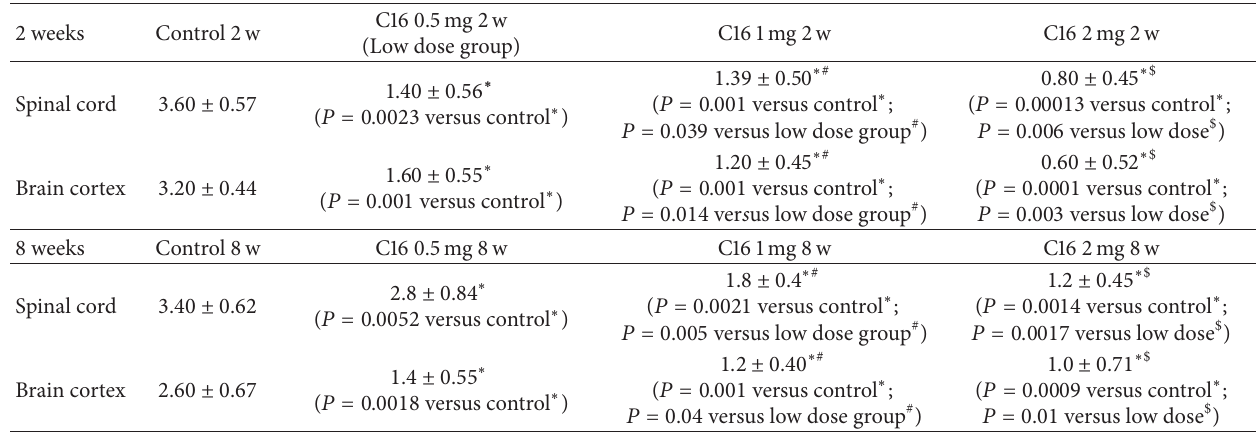
Table 2: Histopathological analysis of demyelination damage in spinal cord (S) and brain cortex (B) of C16 dose dependent treated